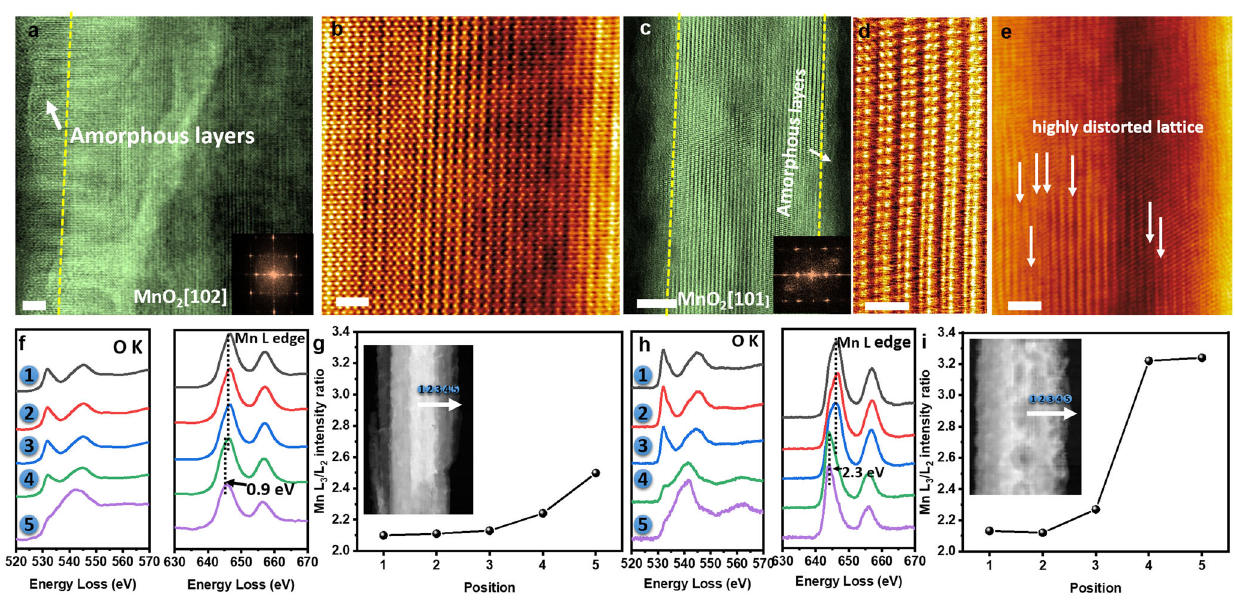
Fig. 4 | Atomic STEM and O-K edge spectra of Zn batteries in dual-cation electrolytes after 100 charge/discharge cycles at the fully discharged state. a , b STEM images of Mg-MnO 2 at the fully discharged state. The inset shows a typical FFT of MnO 2 [102]. Scale bar: a 2.0nm, b 1.0nm. c – e STEM images of Na- MnO 2 at the fully discharged state. The inset shows a typical FFT of MnO 2 [101].